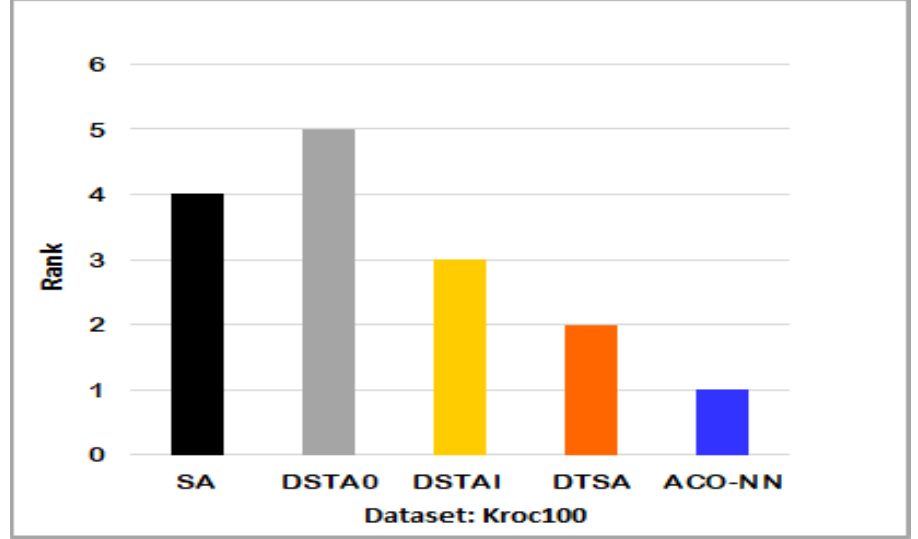
Figure 13. Comparison of rank values for ACO-NN, SA, DSTA0, DSTAI, and